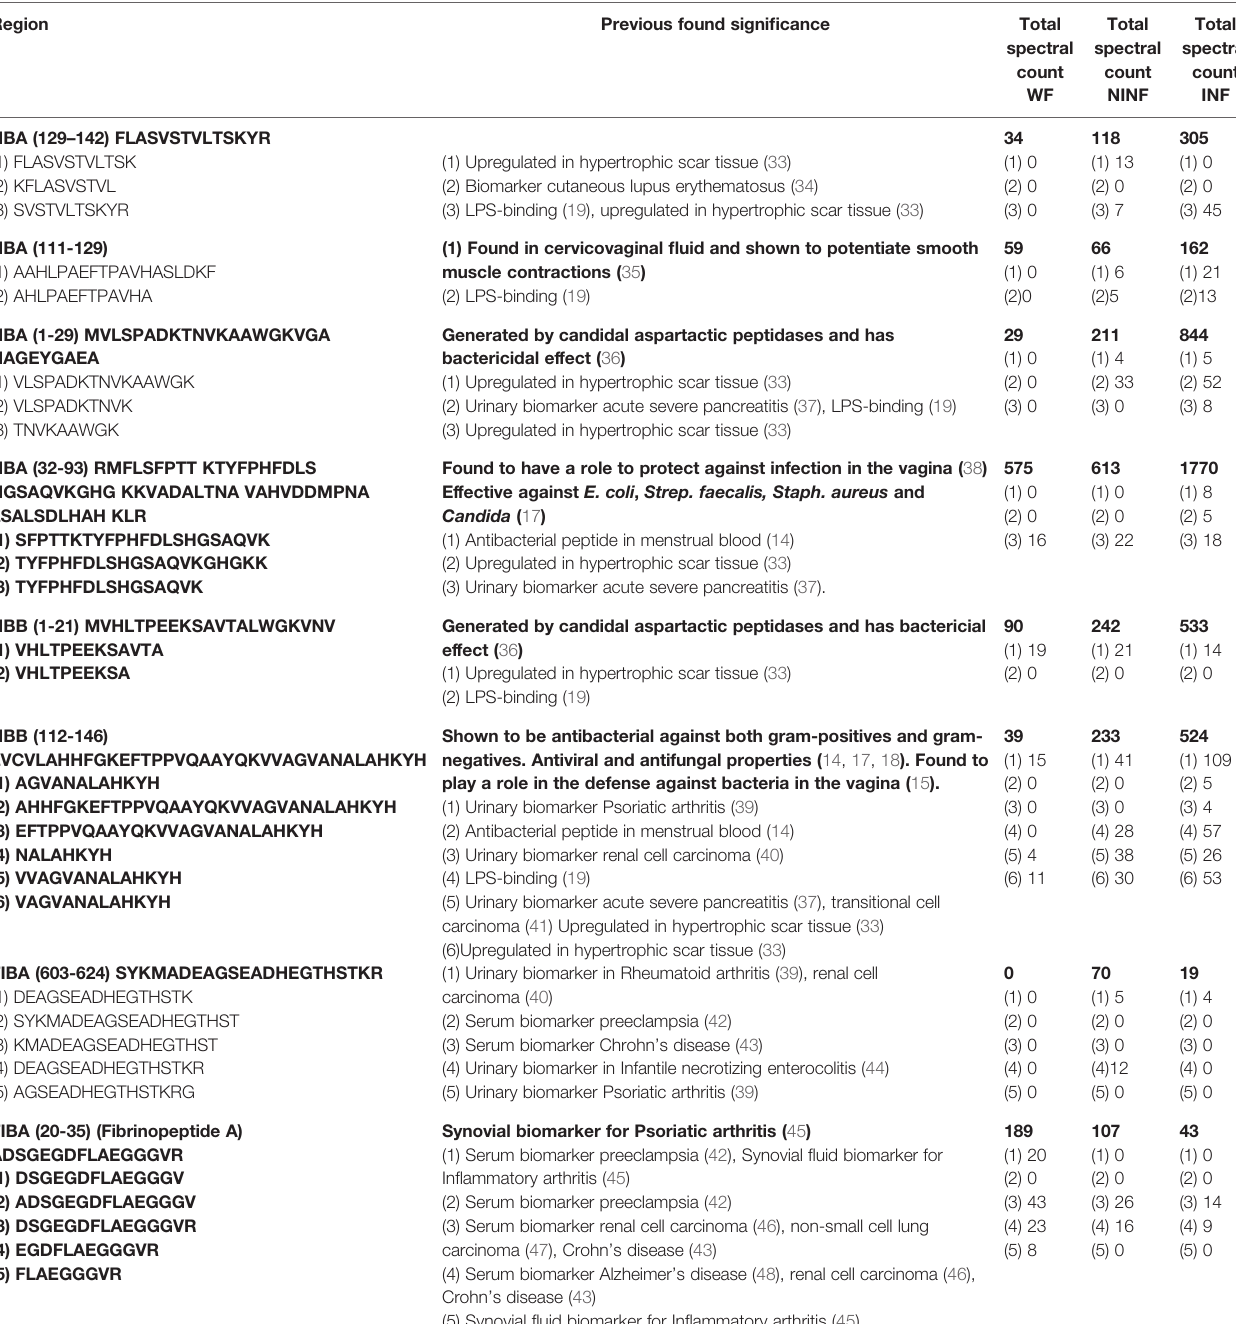
TABLE 1 | Peptides from hemoglobin subunit beta and alpha, as well as fi brinogen alpha validated through previous studies.